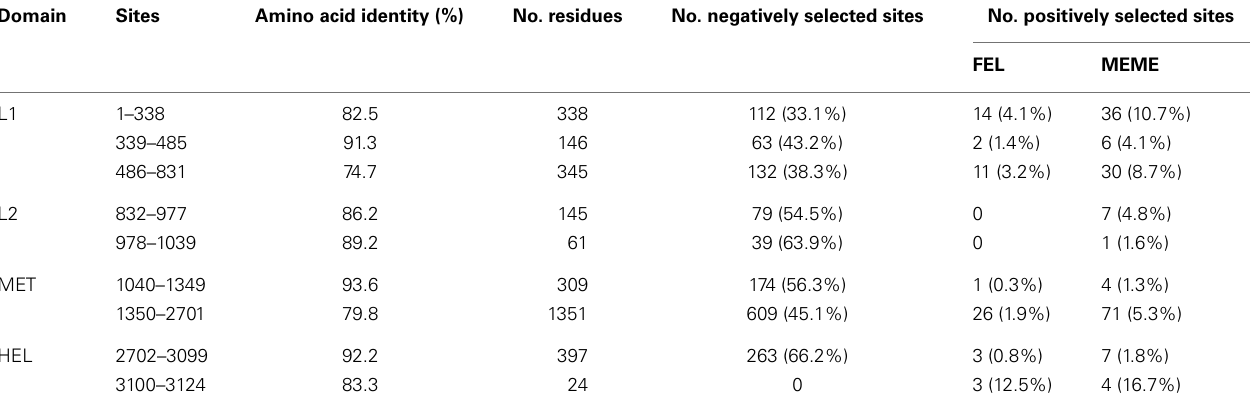
Table 5 | Positively and negatively selected codons present within recognized domains of ORF1a identified by FEL and MEME analysis.